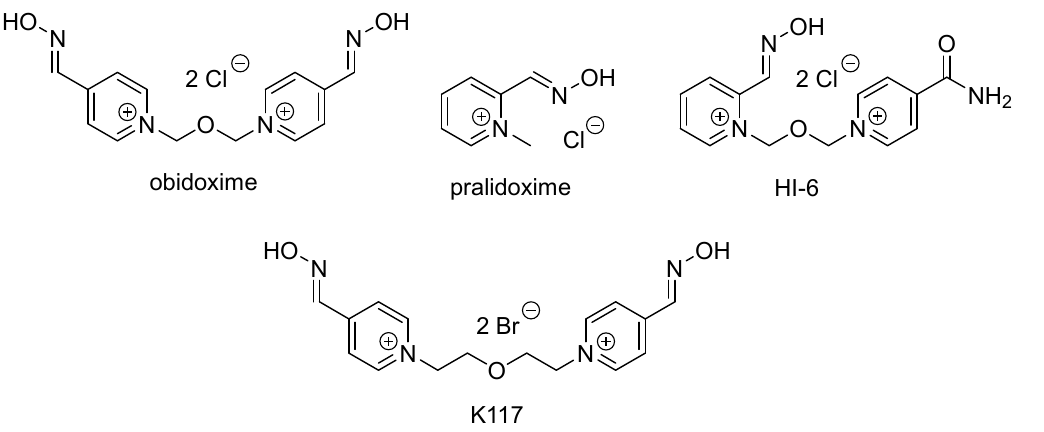
Figure 1. Chemical structures of clinically used AChE reactivators and oxime K117.